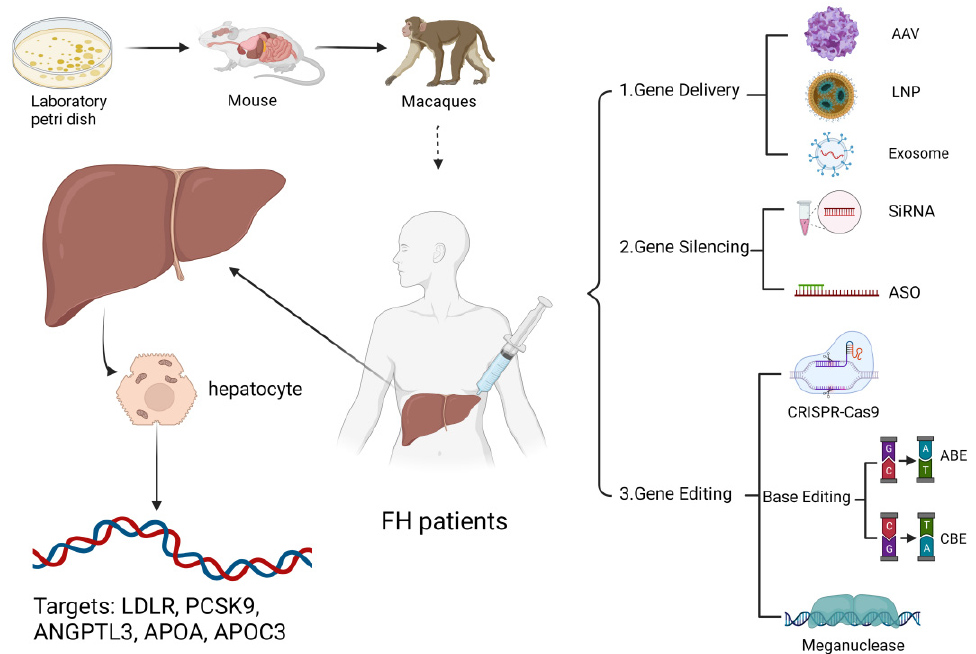
Figure 1. Emerging gene therapy approaches for FH patients. Small interfering RNAs (siRNA) and antisense oligonucleotides (ASO) can inhibit PCSK9 and other targets that are not conducive to lipid-lowering through gene silencing; CRISPER-Cas9, gene editing, and meganuclease can repair dysfunctional LDLR or make LDLR through gene editing. The inactivation of targets that are not conducive to lipid lowering; adenovirus, exosome, and paper nanobody-based delivery tools can deliver the above substances to hepatocytes. (Created with BioRender.com.)